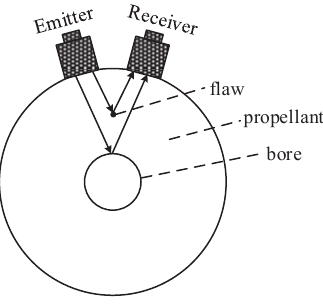
Figure 8. Schematic diagram of the dual-probe echo